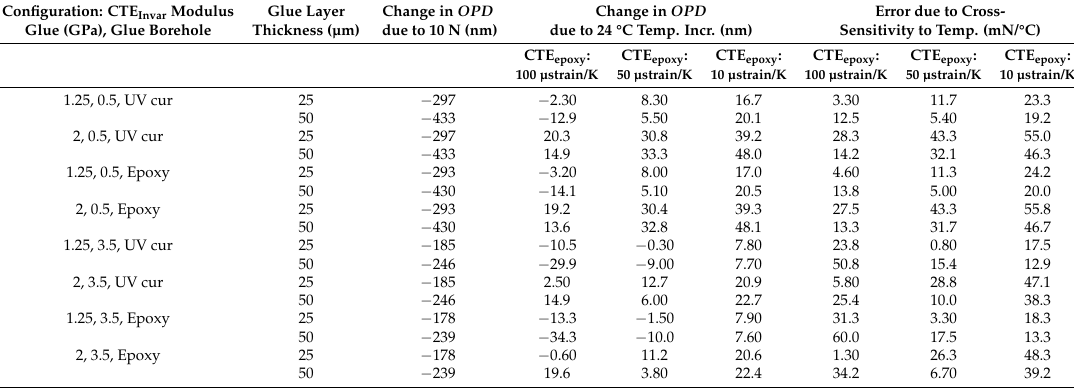
Table 2. Results of FE-analysis of the Invar capillary concept, investigating the sensitivity of the force sensing FPI in the needle tip to force and temperature, as function of the CTE of Invar, the thickness of the epoxy layer between the ferrule and Invar capillary, the modulus of elasticity and CTE of the epoxy and the type of glue used to fix the optical fiber into the ferrule. The needle tip was assumed to be attached rigidly, without a glue layer, to the stylet tube. The FE-model accounts for the elastic modulus and CTE of used materials and the thermo-optic coefficient of air. The sensitivity to force is shown as the change in geometrical cavity length due to an applied axial force of 10 N on the needle tip. The sensitivity to temperature is shown as change in cavity length due to a temperature change of 24 °C. The last three columns show the expected measurement error due to cross-sensitivity to temperature in